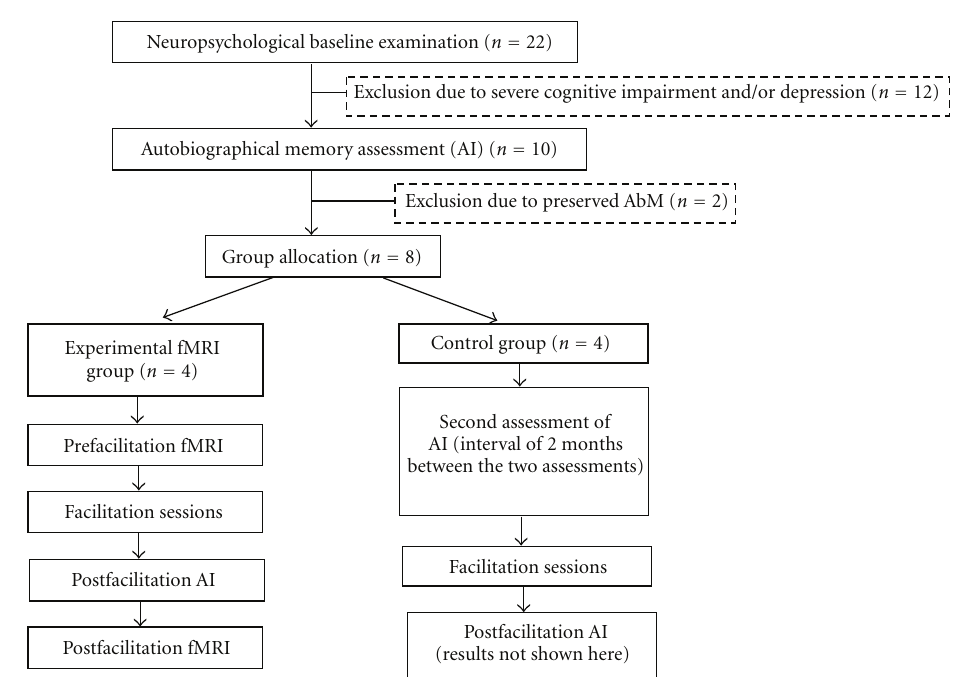
Figure 1: Diagram of the study design and progression trough study